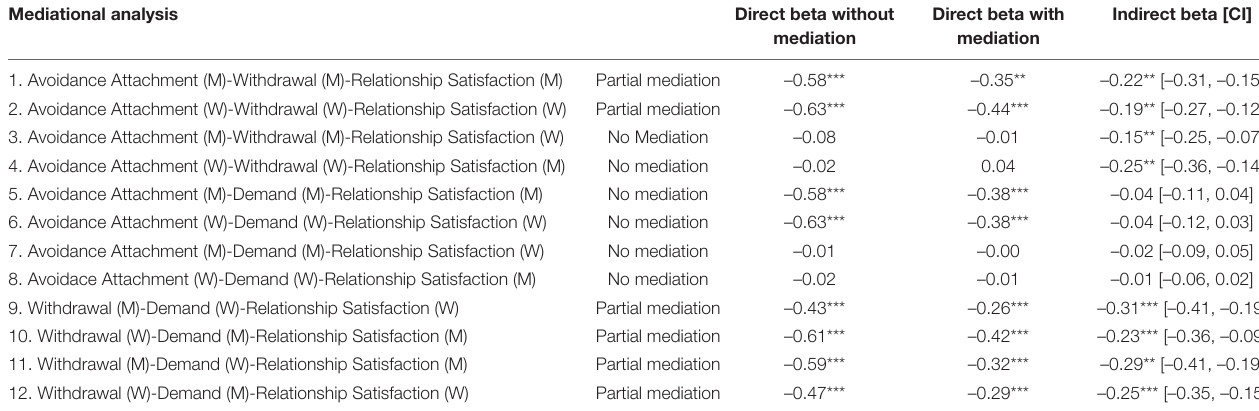
TABLE 5 | Mediation effects in structural equation